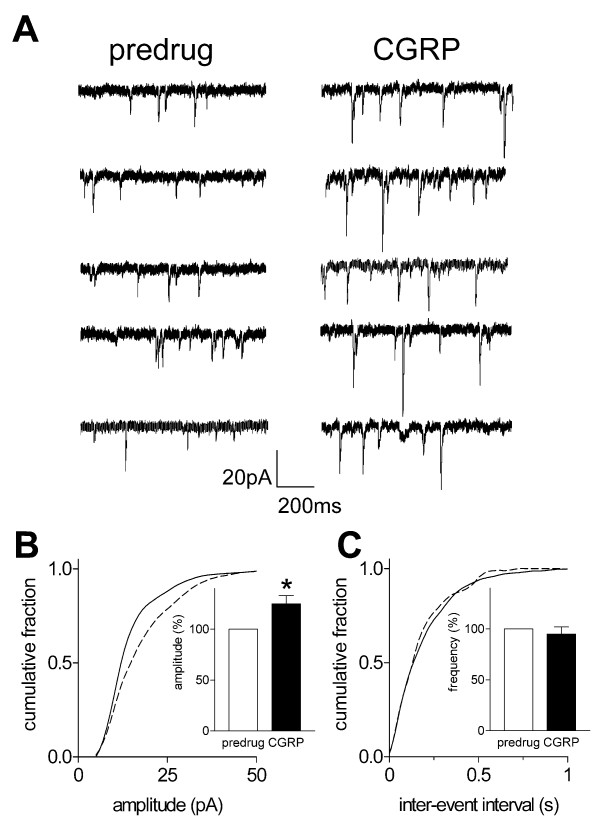
Miniature EPSC (mEPSC) analysis indicates post- rather than pre-synaptic effects of CGRP. A, Original current traces of mEPSC recorded in an individual SG neuron in the presence of TTX (1 μM) show that CGRP (10 nM; 10 min) increases amplitude but not frequency of mEPSCs. B, C: Normalized cumulative distribution analysis of mEPSC amplitude and frequency in the same neuron as in 5A shows that CGRP caused a significant shift toward higher amplitude (B, P < 0.001, Kolmogorov-Smirnov test) but had no effect on the interevent interval (frequency) distribution (C). In the sample of neurons (n = 5) CGRP selectively increased mean mEPSC amplitude (P < 0.05, paired t-test) but not mEPSC frequency (see bar histograms in B, C). Symbols and error bars represent mean ± SEM. Neurons were recorded in voltage-clamp at -60 mV. * P < 0.05.